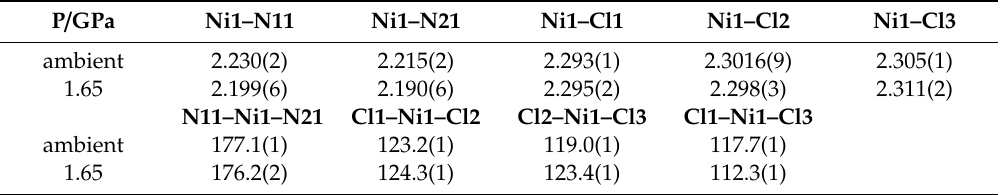
Table 8. Selected distances (Å) and angles ( ◦ ) in compound 13 as a function of pressure (GPa). P /